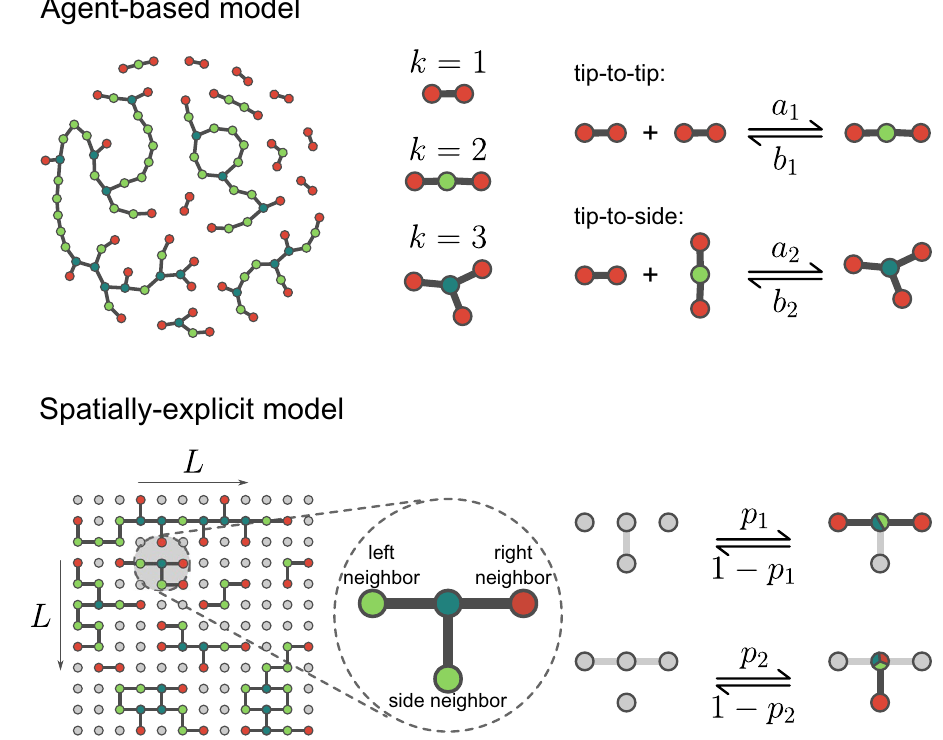
Figure 2. The two models of mitochondrial network dynamics used in this work. In the agent-based model, network nodes do not have explicit spatial coordinates. The final topology of the network emerges from the iteration of two types of events: tip-to-tip events, in which two k = 1 units are merged into a k = 2 unit (or vice versa), and tip-to-side events, in which a k = 1 unit and a k = 2 unit are merged into a k = 3 unit (or vice versa). In the spatially-explicit model, the network nodes are embedded in a 2-dimensional lattice with predetermined nearest neighborhood interactions. Interactions are anisotropic: a bond is established between a node and its left and right nearest neighbors with probability p 1 (or destroyed with probability 1 − p 1 ) and with its side nearest neighbor with probability p 2 (or destroyed with probability 1 − p 2